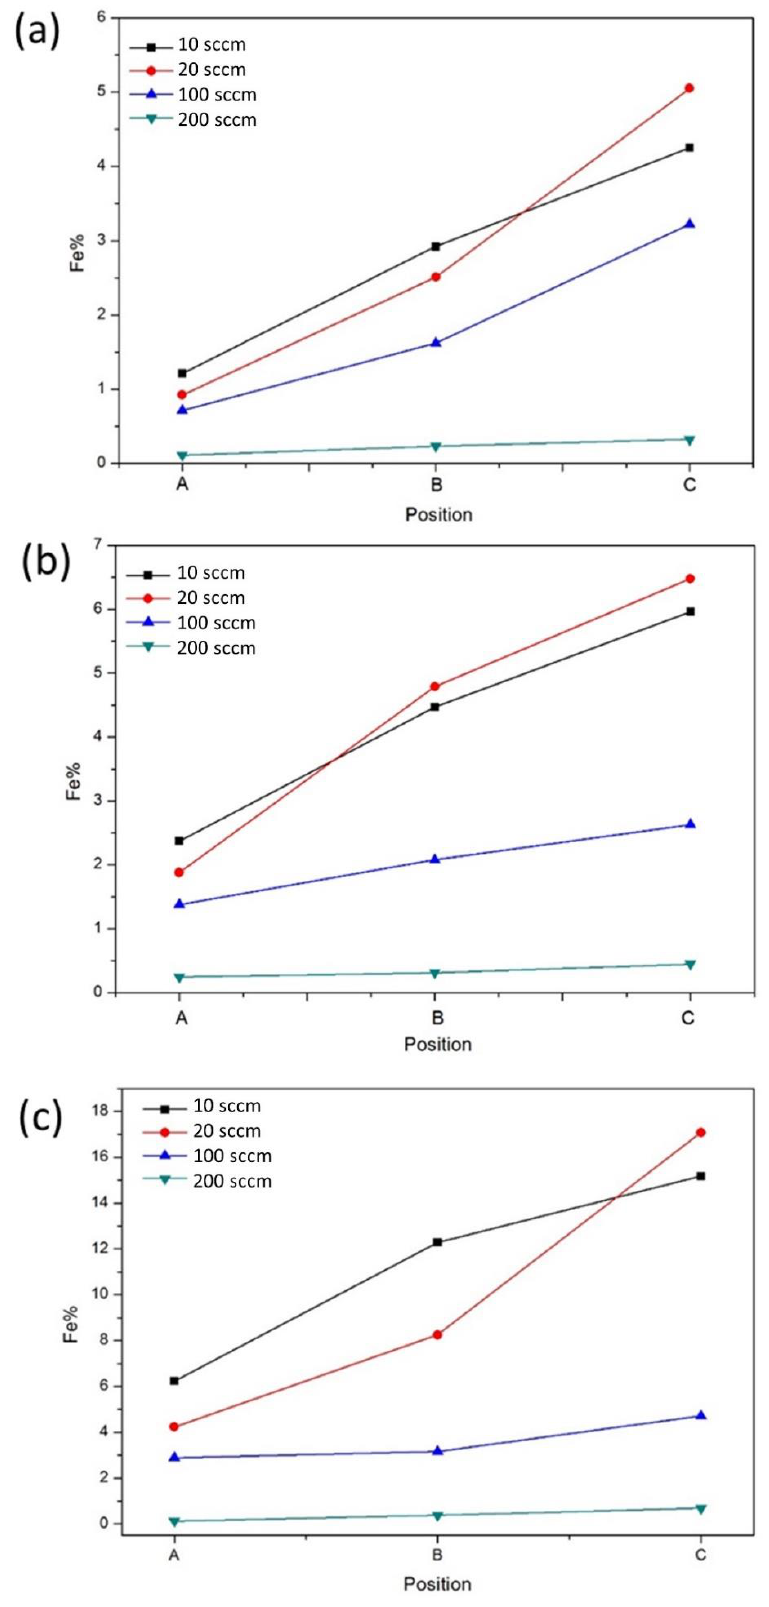
Figure 6. The EDX analysis of Fe on the substrate for different temperatures: ( a ) 650 °C, ( b ) 850 °C, and ( c ) 1000 °C.